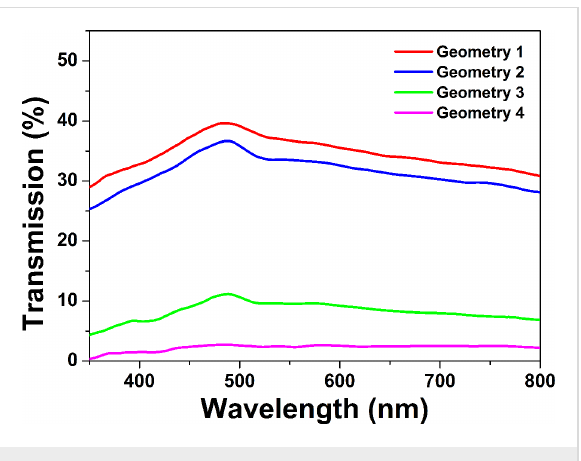
Figure 5: Optical transmission spectra of the Au nanostructures deposited at different